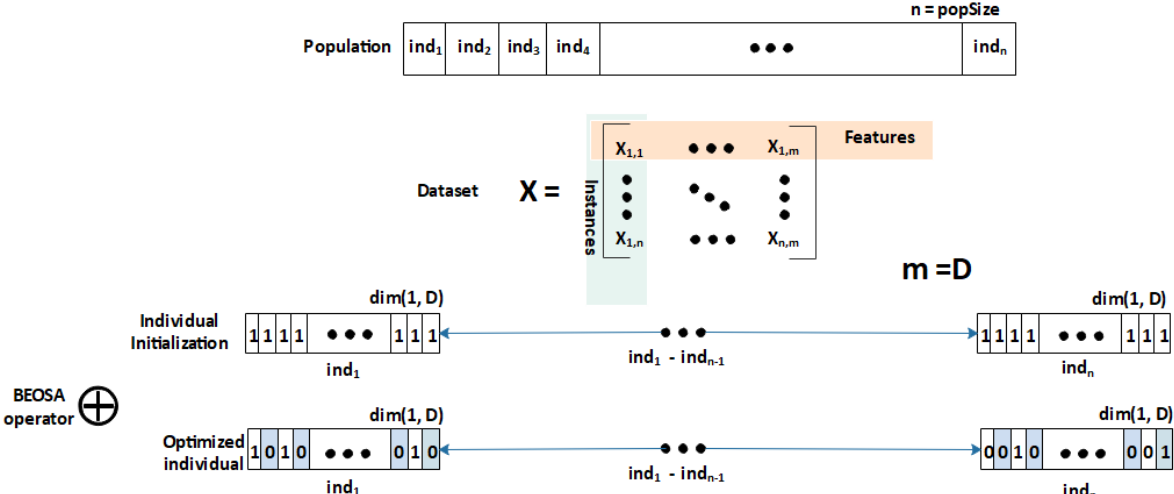
Figure 1. Representation of the search space for all individuals in the population, with an illustration of the binarization procedure of feature indicators for each individual.